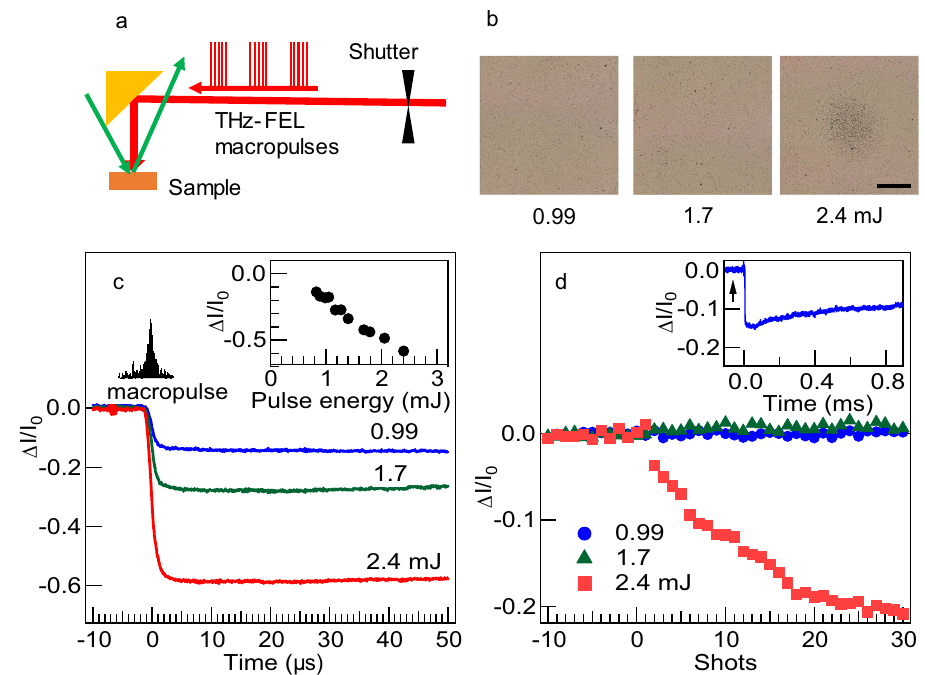
Fig. 4 THz-induced temporal evolution of the surface roughness. a The experimental setup. The green arrows indicate the re fl ection measurement using visible light. b The photographs of the three spots after irradiation with the fi fty THz macropulses for the three pulse energies used (0.99, 1.7, and 2.4 mJ). The contrast of these are adjusted to show the changes in the irradiation spot clearly. The length of the black scale bar corresponds to 100 μ m. c The time dependences of the changes in Δ I = I 0 observed after the fi rst macropulse for 0.99, 1.7, and 2.4 mJ. The inset shows the macropulse energy dependence of Δ I = I μ s after excitation. d Dependences of the irreversible component in Δ I = I 0 at a time of 10 0 on the number of macropulse shots for 0.99, 1.7, and 2.4 mJ. For this, we plotted the Δ I = I 0 observed immediately before the following macropulse as shown by the arrow in the inset. The inset shows the Δ I = I 0 pro fi le in Fig. 4c for 0.99